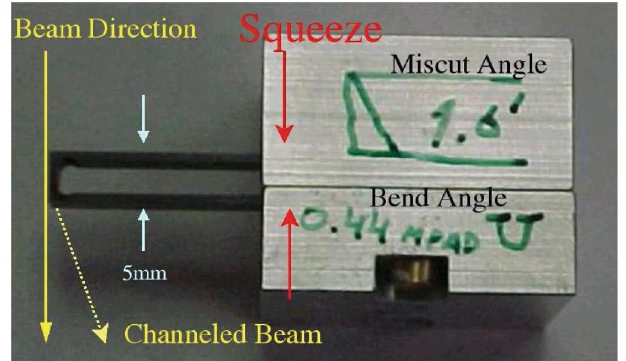
FIG. 6. (Color) The RHIC crystal. The RHIC beam enters the picture from the top. Channeled beam is diverted to the